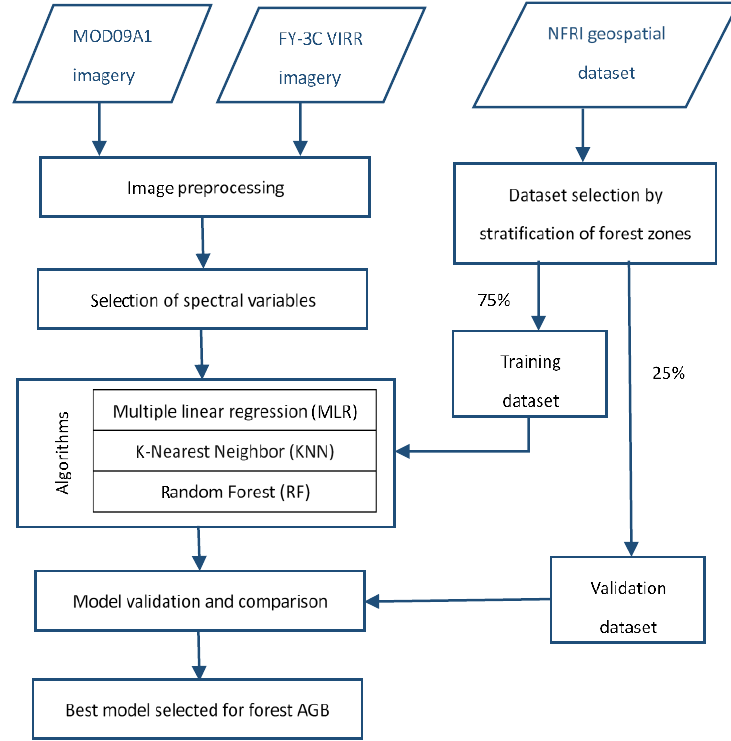
Figure 2. The flowchart of methodology.